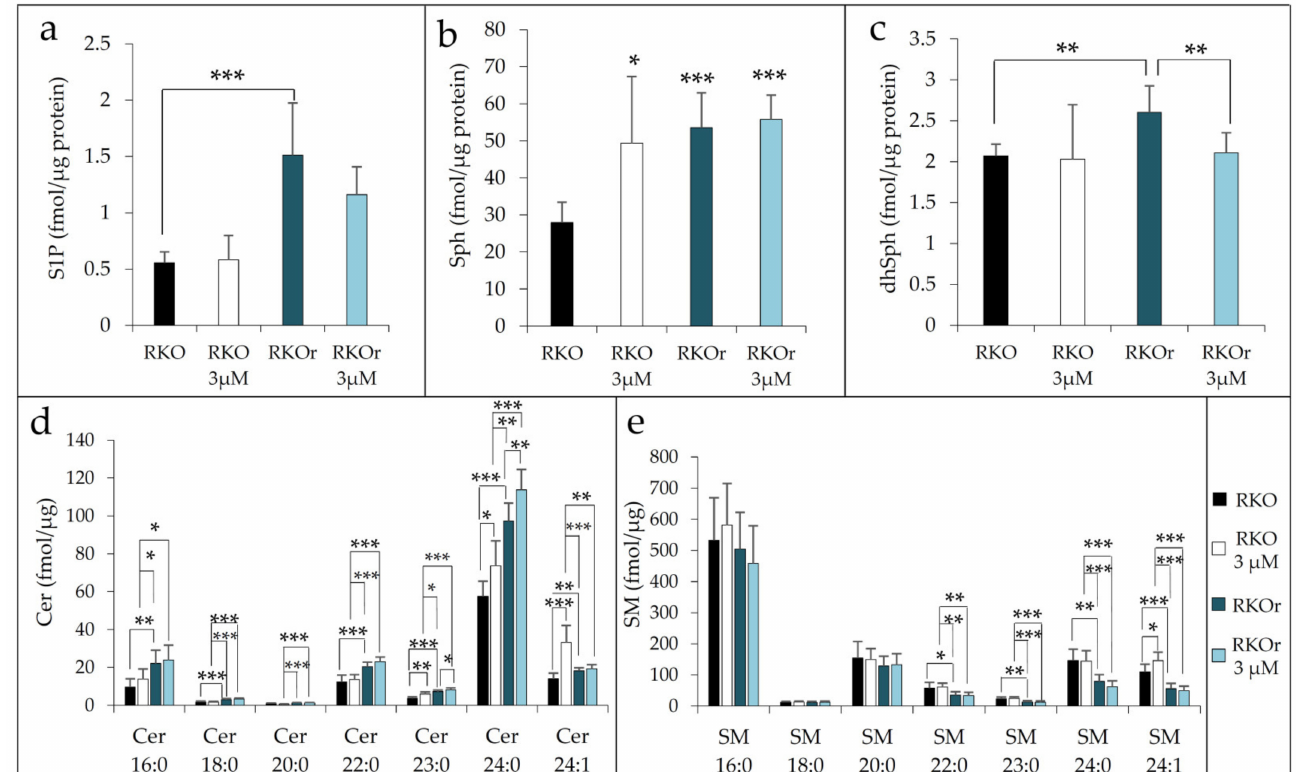
Figure 3. Sphingolipidomic analysis of different sphingolipid species using ultra-high-performance liquid chromatography coupled with triple quadrupole mass spectrometry (UHPLC/MS/MS) in sensitive (RKO) and vemurafenib-resistant (RKOr) cells under basal conditions (no treatment) and treated with 3 µ M PLX4032 for 48 h. Cellular lipids were extracted, quantified by mass spectrometry and normalized to protein content. Results are expressed as fmol/ µ g protein concentration and represent the levels of S1P ( a ), sphingosine (Sph) ( b ), dihydrosphingosine (dhSph) ( c ), ceramides (Cer) ( d ) and sphingomyelins (SM) ( e ). Asterisk denotes statistical significance (* p < 0.05, ** p < 0.01, *** p < 0.001). Results were obtained from three individual biological experiments performed in two technical